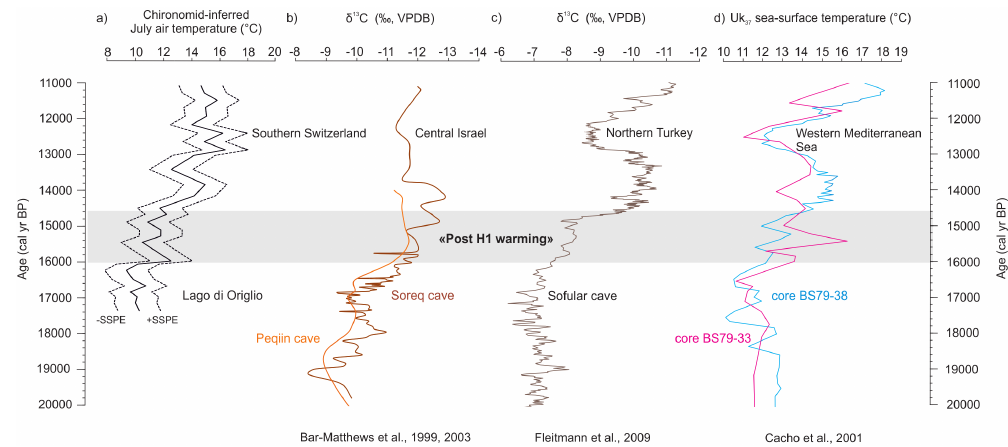
Fig. 7. (a) Chironomid-inferred July air temperature estimates (including sample specific error of prediction: SSPE), (b) carbon isotope data from Soreq and Peqiin caves in central Israel (Bar-Matthews et al., 1999, 2003) and (c) from Sofular cave in northern Turkey (Fleitmann et al., 2009), and (d) alkenone-derived sea surface temperature data from two sediment cores (BS79-33 and BS79-38) from the western Mediterranean Sea (Cacho et al.,